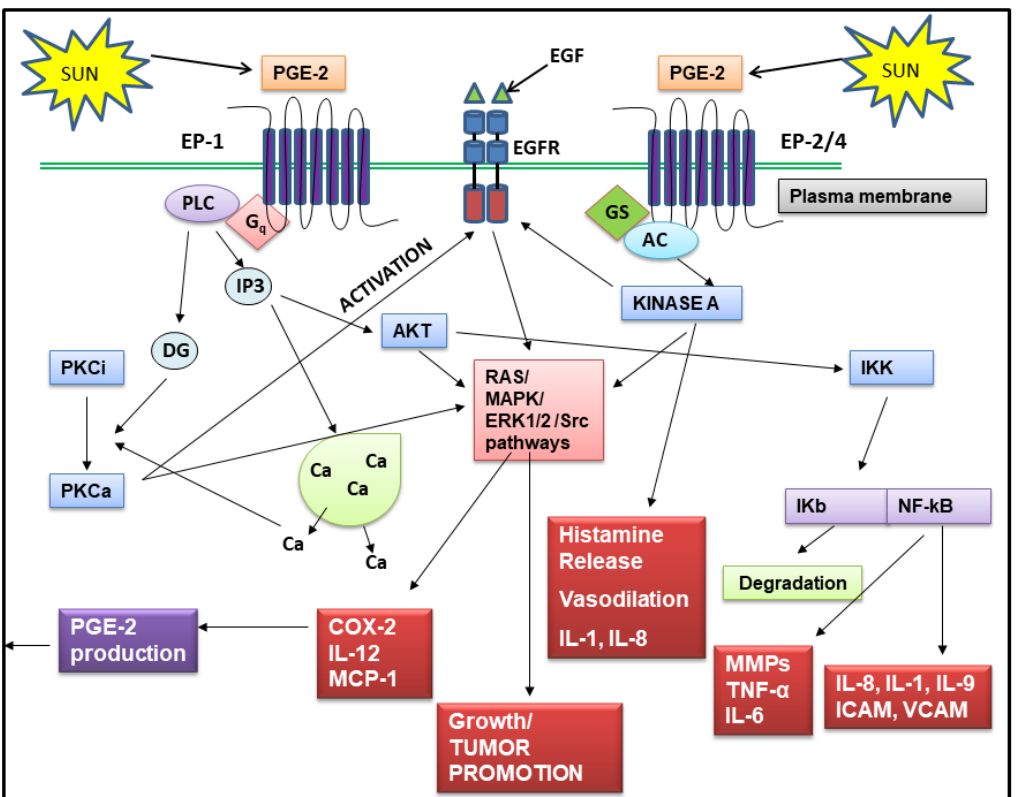
Figure 3. Diagram showing the variety of PGE-2 signaling pathways and inflammatory mediators produced in cells that express EP1 – EP4 receptors. The EP1 receptor activates a Gq protein that activates phospholipase C producing diacylglycerol (DG) and Inositol triphosphate (IP3). Diacylglycerol activates protein kinase C (PKC). The EP2, and EP4 receptors are coupled to a Gs protein that activates adenylate cyclase, leading to increase cAMP production. cAMP activates Kinase A, and this kinase can activate other signaling pathways. EP3 (not shown) is coupled to a G protein that prevents an increase in cAMP. EP4 also activates the PI3/AKT pathway levels to increase cAMP levels. In addition to effects of PGE-2 in regulating genes that cause skin aging, evidence shows a role for EP1, EP2, and EP4, but not EP3 in the development of skin cancer.